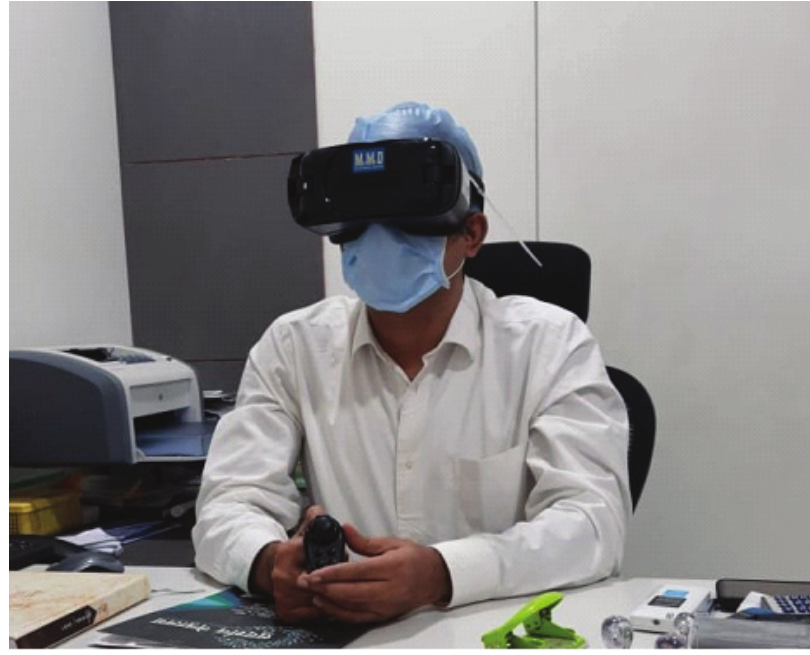
Figure 1. Figure showing the use of the instrument in a